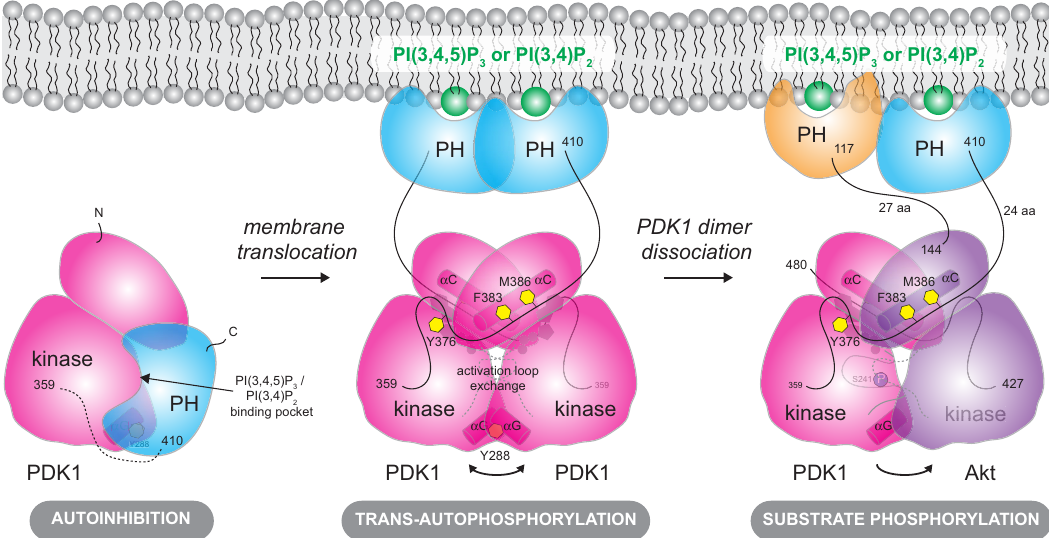
Fig. 6 Model of phosphoinositide-driven PDK1 activation. Cytosolic PDK1 is inhibited by its PH domain. PIP 3 binding relieves autoinhibition by displacing the PH domain from the dimerization surface and catalytic cleft of the kinase domain. Dimerization of the PH domain upon PIP 3 binding leads to PDK1 kinase domain dimerization, interdomain linker exchange (which includes the speci fi c binding of NFD and hydrophobic motifs), and trans -autophosphorylation of the activation loop on S241. Upon trans -autophosphorylation, the phosphorylated kinase domain dimer dissociates, rendering it competent to bind and phosphorylate downstream substrate kinases. The substrate kinase Akt is used to illustrate the fi nal step in PDK1-mediated downstream kinase activation (far